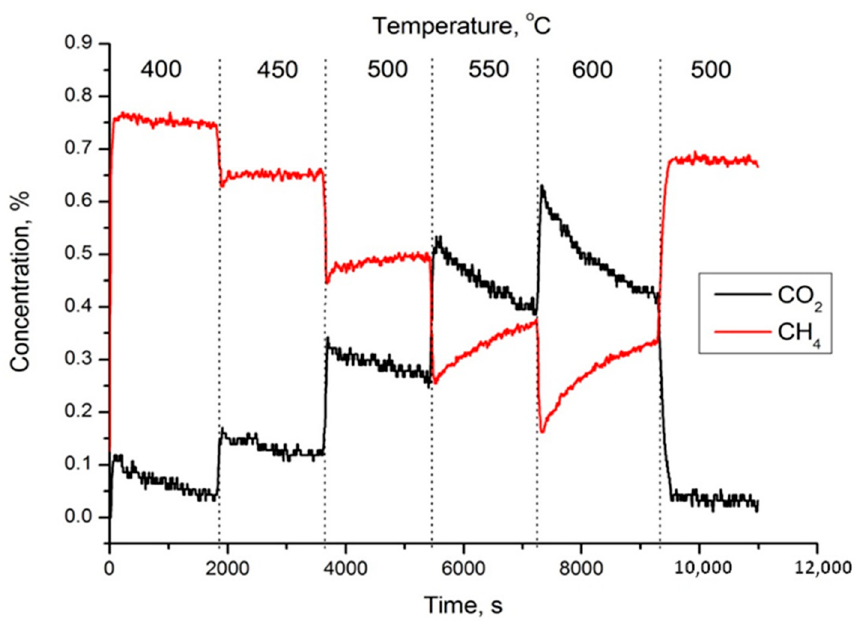
Figure 1. Dependence of the degree of methane conversion on temperature and time.